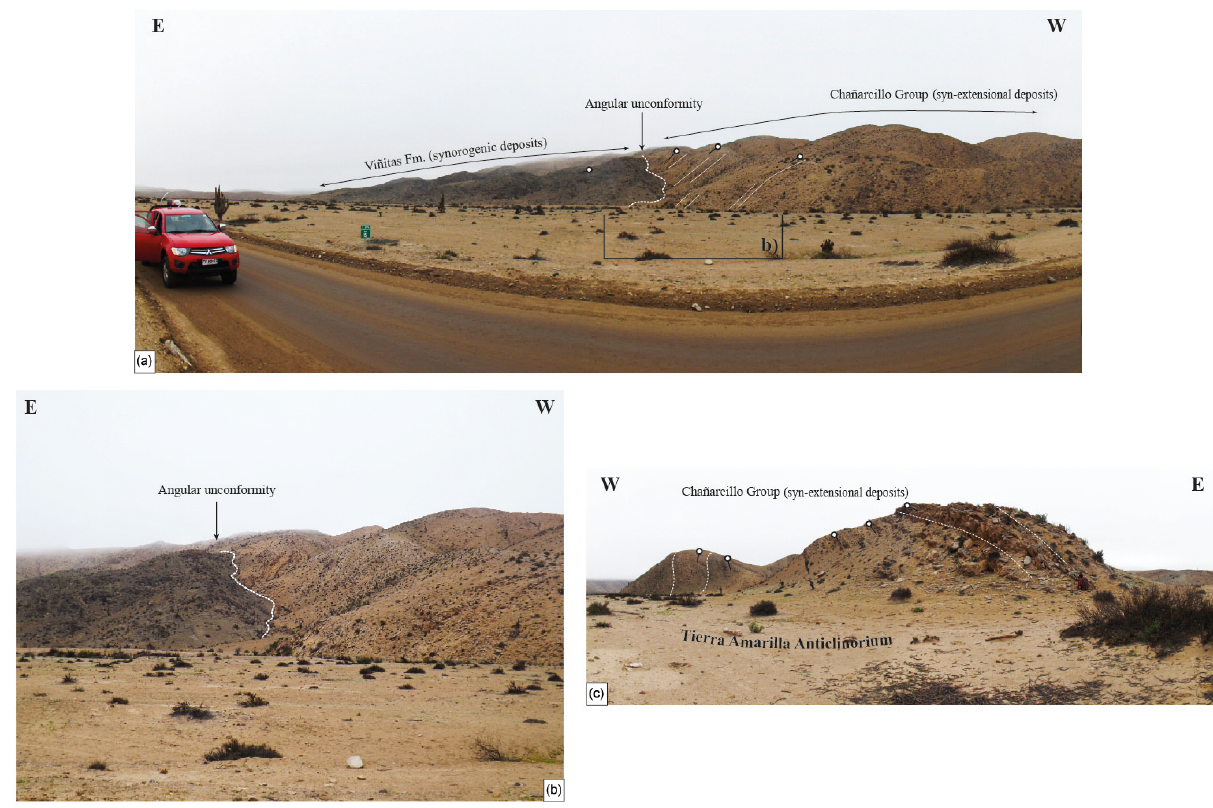
Figure 8. (a) E–W panoramic view of the angular unconformity between the synorogenic deposits of the Viñitas Formation and the Pabellón Formation along the frontal limb of the Tierra Amarilla Anticlinorium (see location in Fig. 3); (b) detail of the contact between the synrift deposits of the upper section of the Chañarcillo Group and the synorogenic deposits of the Viñitas Formation (see location in Fig. 3); (c) aspect of the inclined frontal limb of the Tierra Amarilla Anticlinorium (see location in Fig.